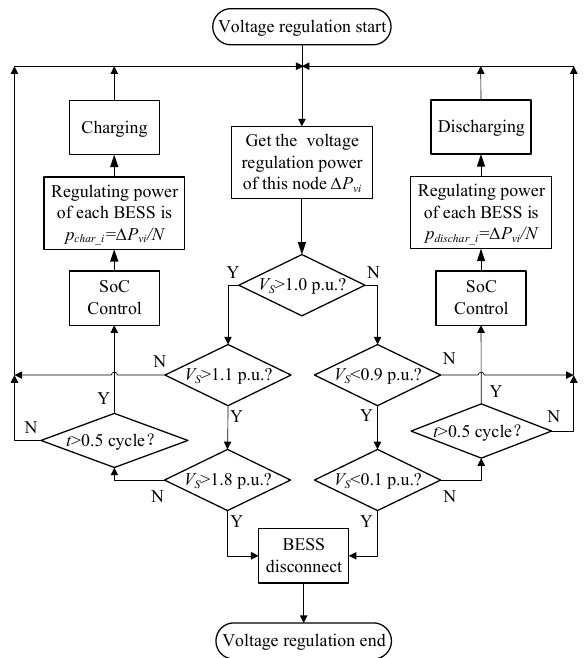
Figure 4. Battery energy storage systems (BESS) voltage r egulation block diagram.